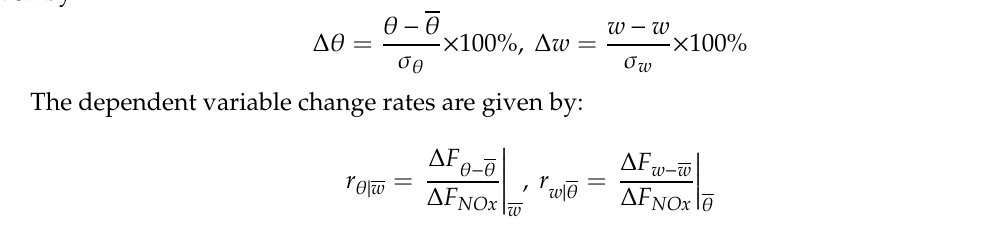
R of the ring roads measured on April 18th and 20th. Group A’s main error source is Figure 9. The 2 i the wind direction uncertainty. Group B’s main error source is the wind speed uncertainty. Group C’s main error is both the wind direction uncertainty and the wind speed uncertainty.